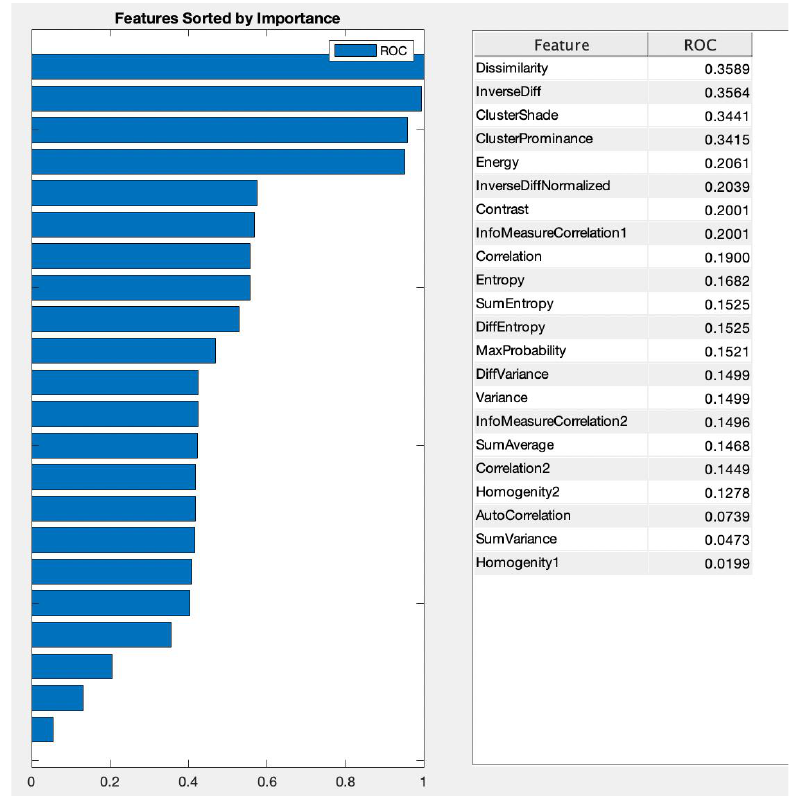
Figure 2. Feature ranking based on entropy values.